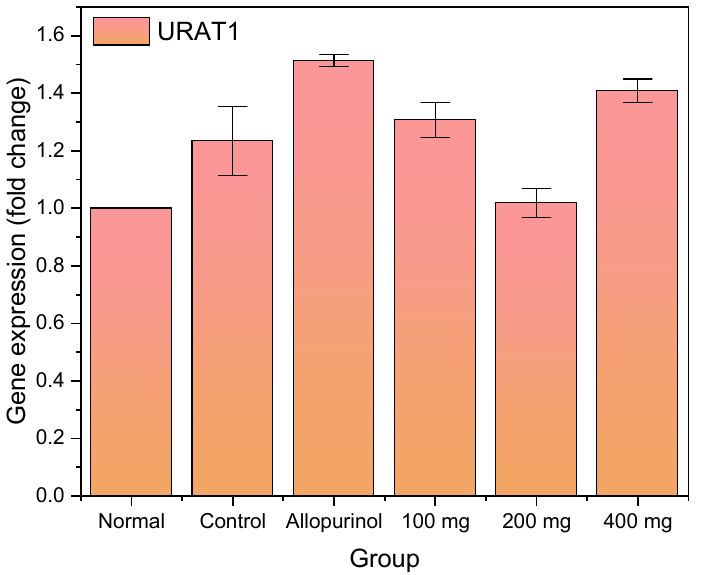
Figure 3. Relative expression of urate transporter 1 normalized with endogenous β -actin.